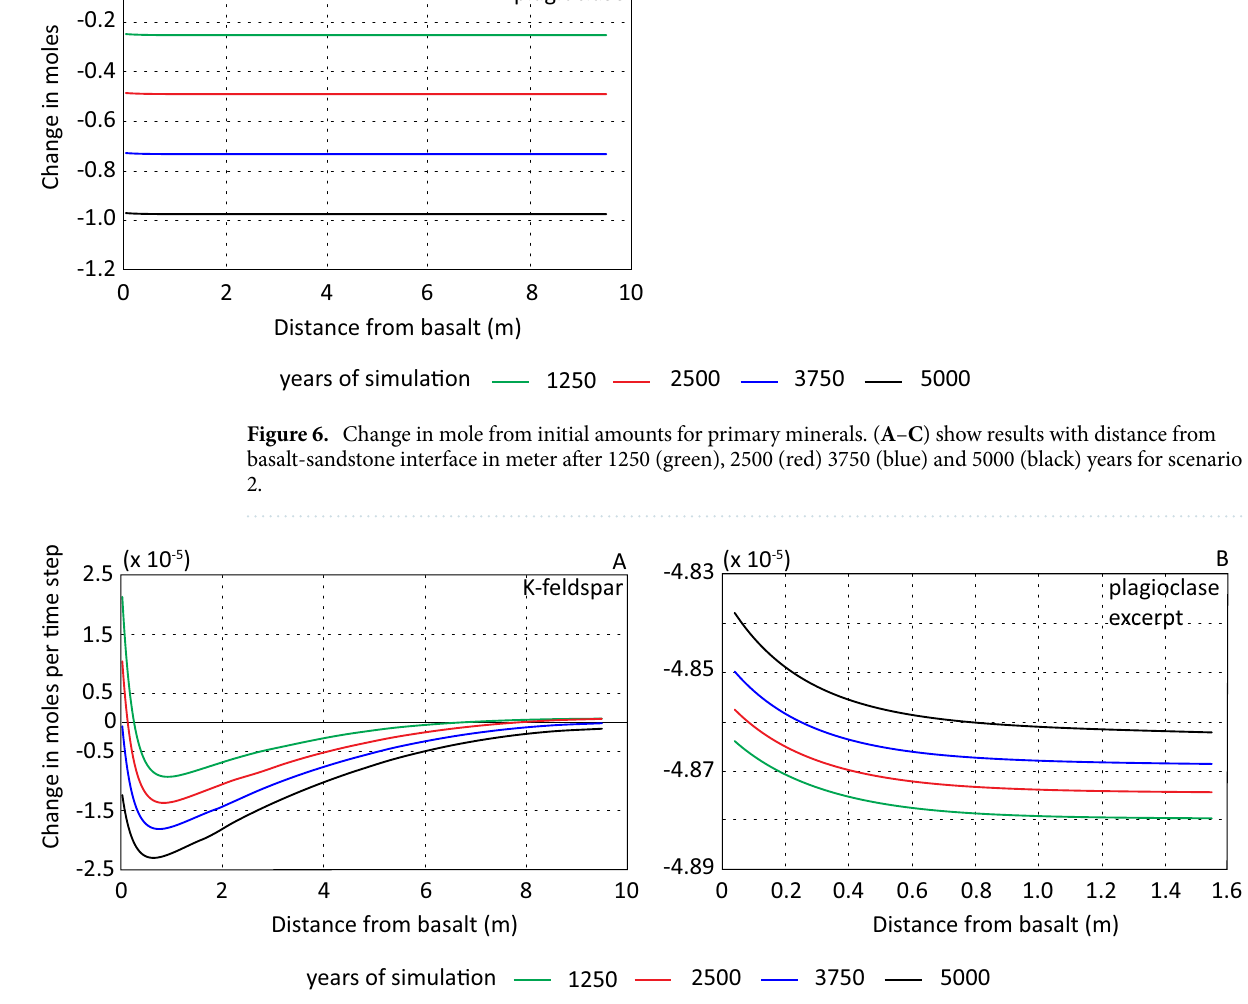
Figure 7. Change in mol (rate) of K-feldspar ( A ) and plagioclase ( B ) as a function of time and distance from basalt displayed for scenario 2. Note difference in